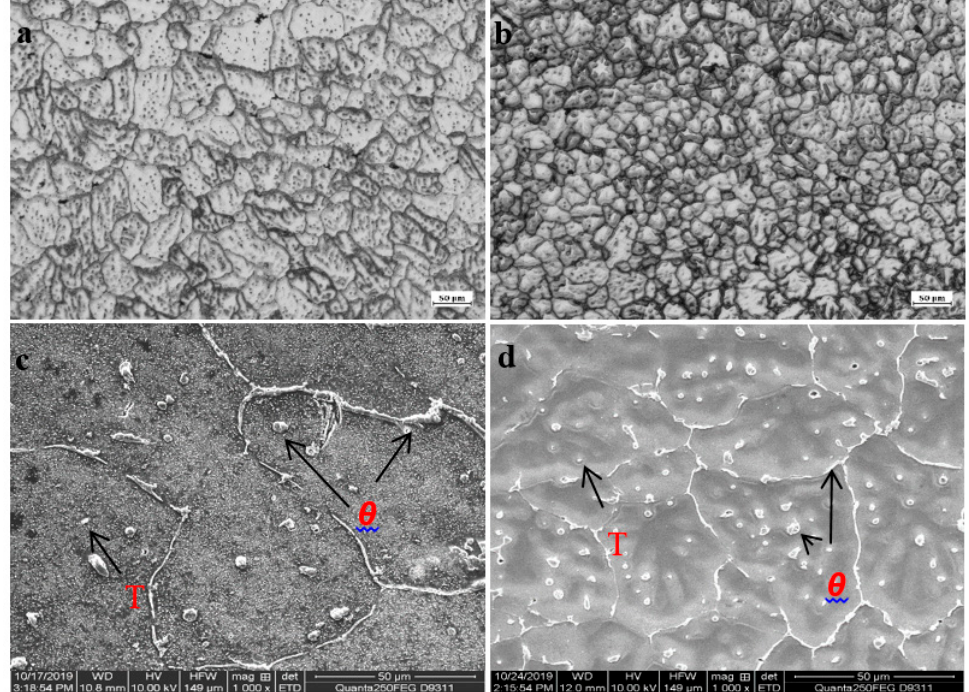
Figure 4. Metallographs of ( a ) single-wire wall and ( b ) double-wire wall; and SEM images of ( c ) single-wire wall and ( d ) double-wire wall in as-deposited state respectively.